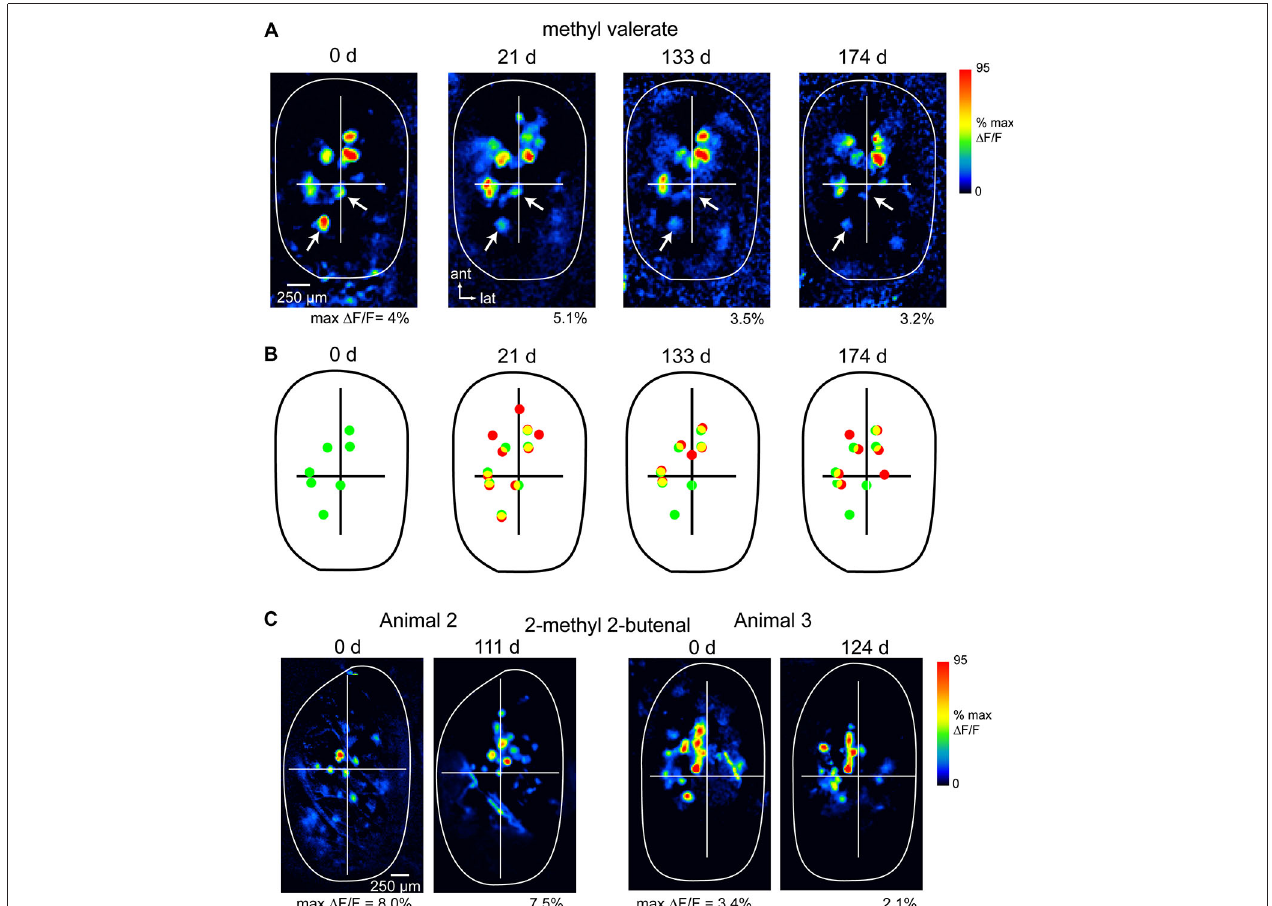
amplitudes over time. Maps were smoothed with a Gaussian kernel ( σ = 25 µ m, kernel width = 70 µ m) for display. (B) Comparison of spH signal foci locations for responses at day 0 and each later time-point, taken from maps in (A) . Dots identify signal foci with amplitudes above 30% of maximal amplitude. Green dots indicate foci in initial session, red indicates foci in the current session, yellow indicates colocalized foci. (C) spH response maps for two additional animals imaged at 111 and 124 days time-points; odorant: 2-methyl